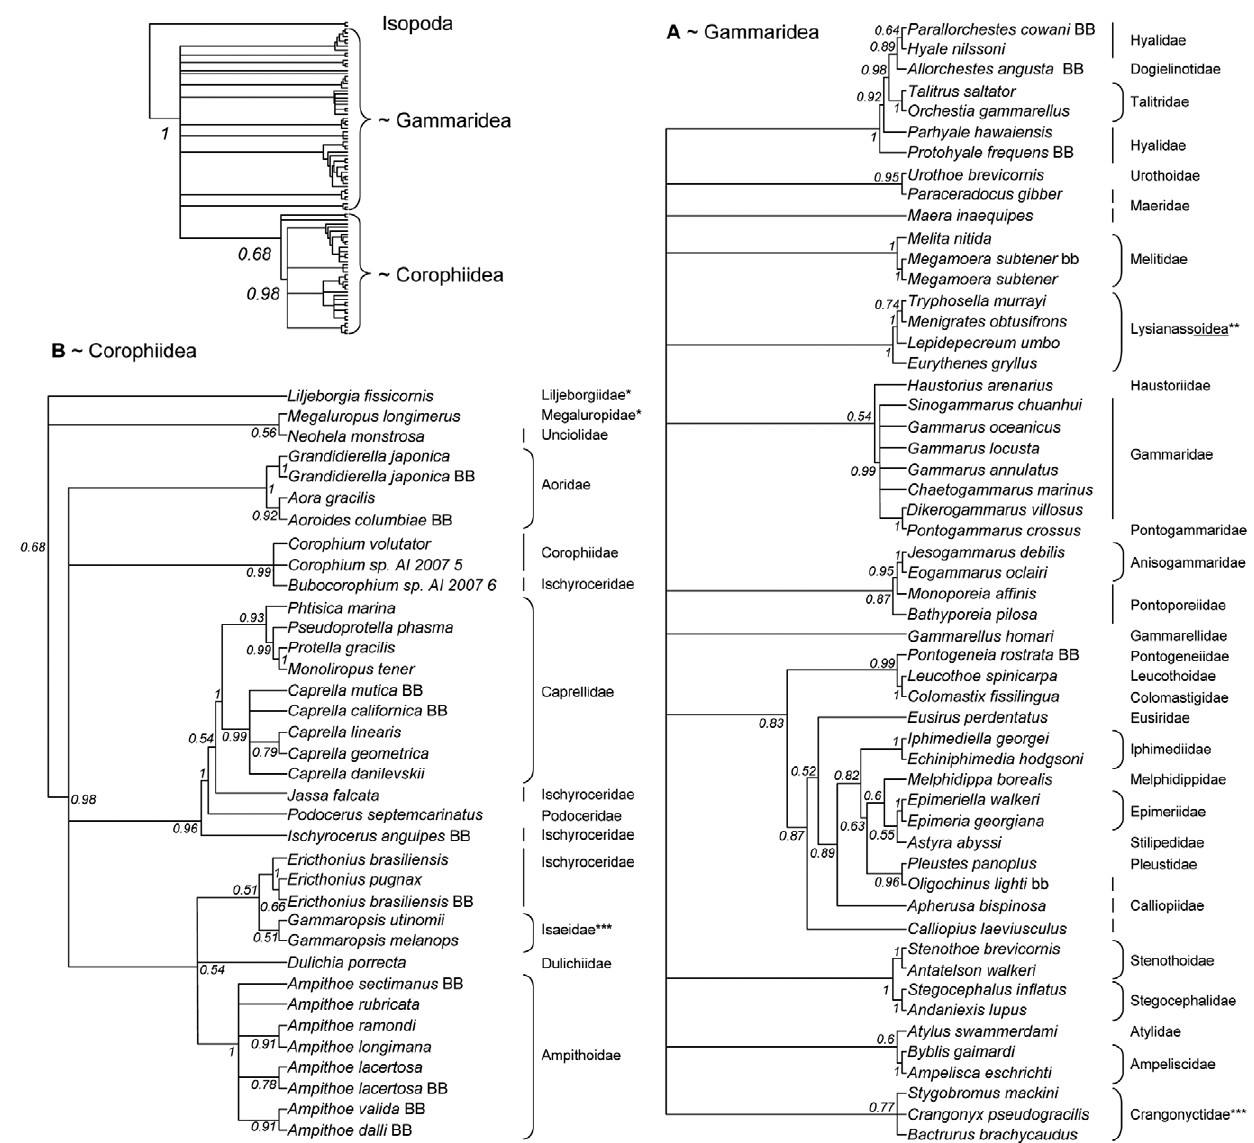
Figure 2. 50% majority rule consensus cladogram for all 88 species based on the nuclear gene 18S. Node labels give posterior probabilities. Branch lengths are not meaningful. As shown in the upper left diagram, the cladogram consists of the Isopoda outgroup, and two subsections: A) suborder Gammaridea, and B) suborder Corophiidea. Two species (*) are grouped with the Corophiidea (although with low support), but are classified as Gammaridean. Rounded brackets show families with monophyletic topologies, plus the monophyletic superfamily Lysianassoidea (**). Monophyly brackets are supported with probability . 0.99 with the exception of two families marked with ***. Non-monophyletic families are marked with vertical lines; families with no marking are represented by 1 species. New sequences from Bodega Bay are marked with BB for the 14 amphipod species with trait data and bb for the 2 without.